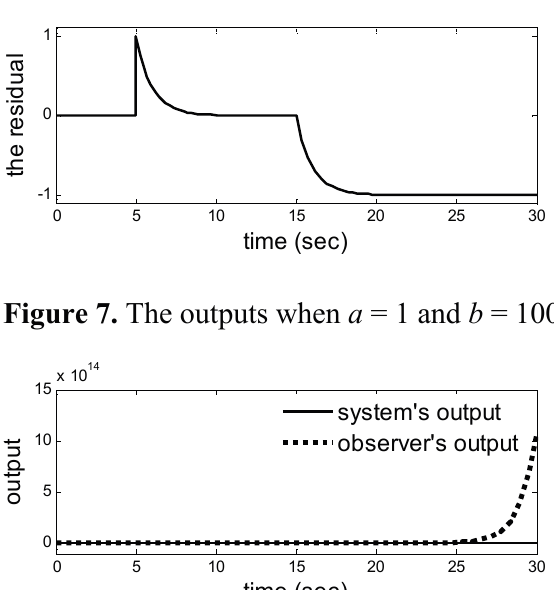
Figure 6. The residual when a = − 1 and b = 4.